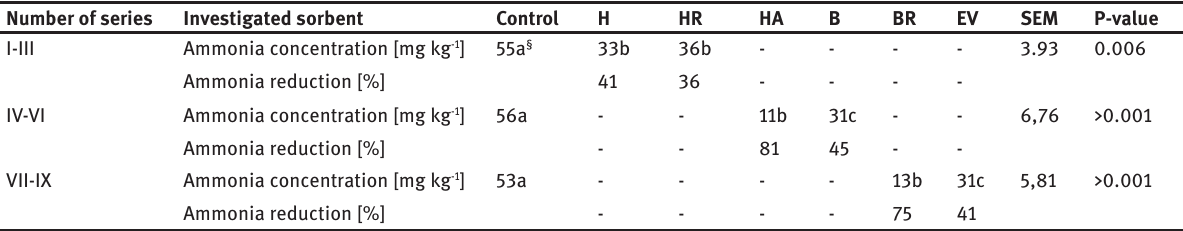
Table 1: Effect of aluminosilicates on reduction of ammonia concentration inside the chambers (mean, n=3). Number of series Investigated